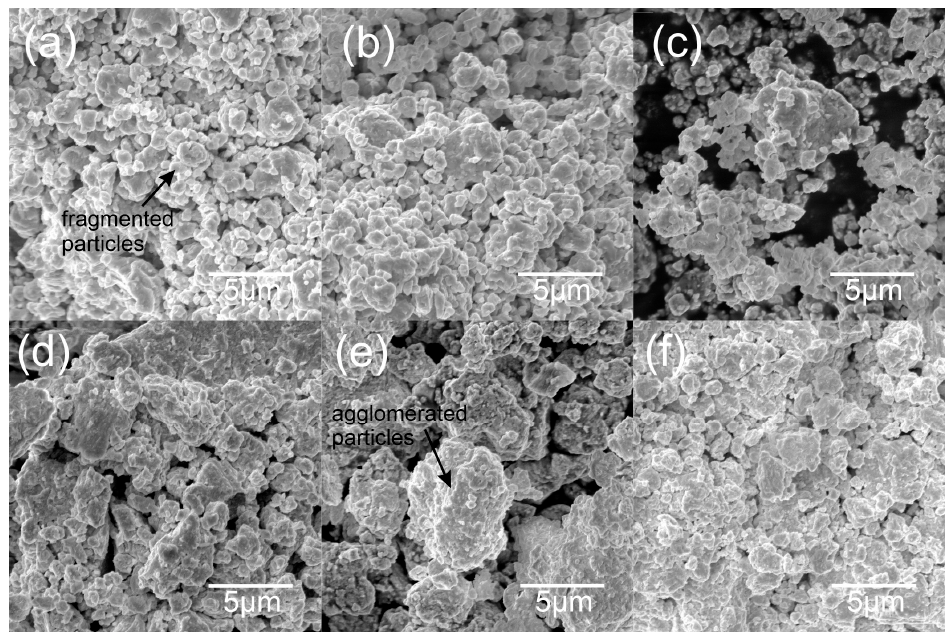
Figure 7. Linear Williamson–Hall plots with an obtained equation based on the XRD spectra of NiAl-xWC powder after 10 h of mechanical alloying.